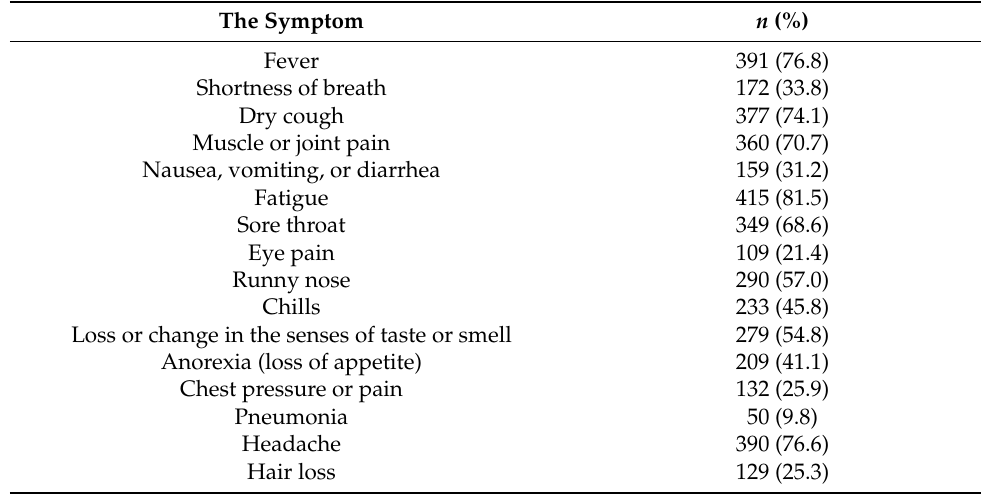
Table 2. The proportion of experienced symptoms reported by study subjects ( n = 509) who previously developed COVID-19